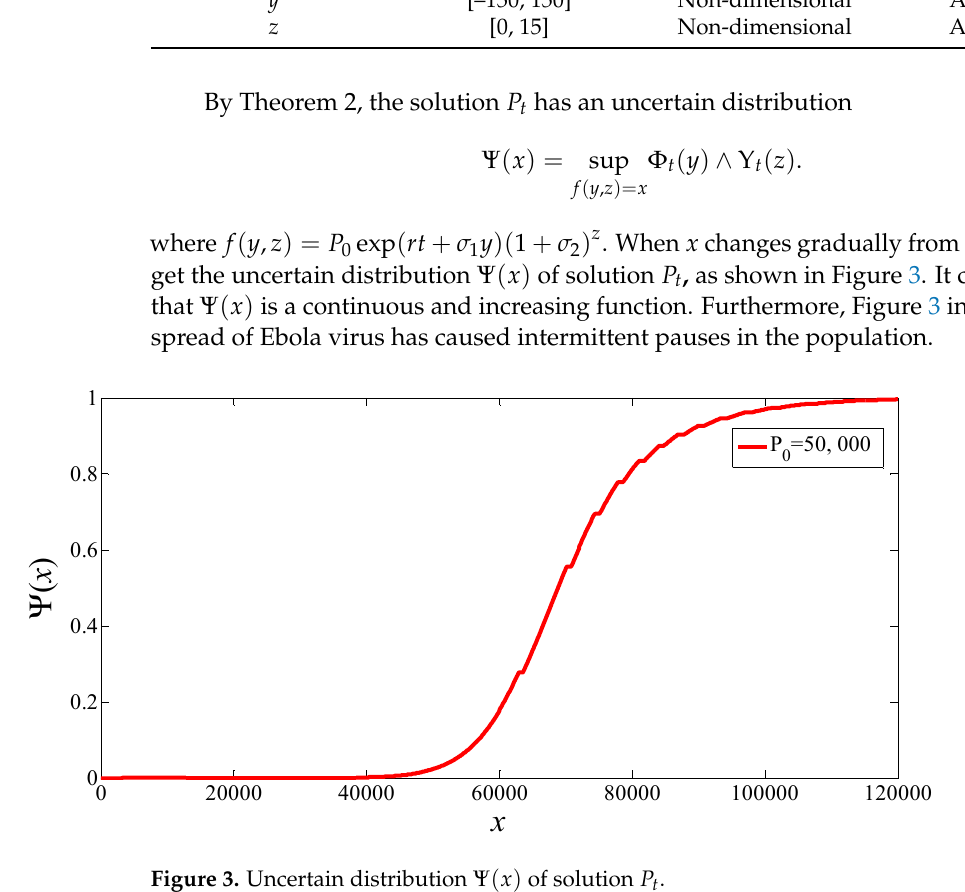
Figure 3. Uncertain distribution ( ) x